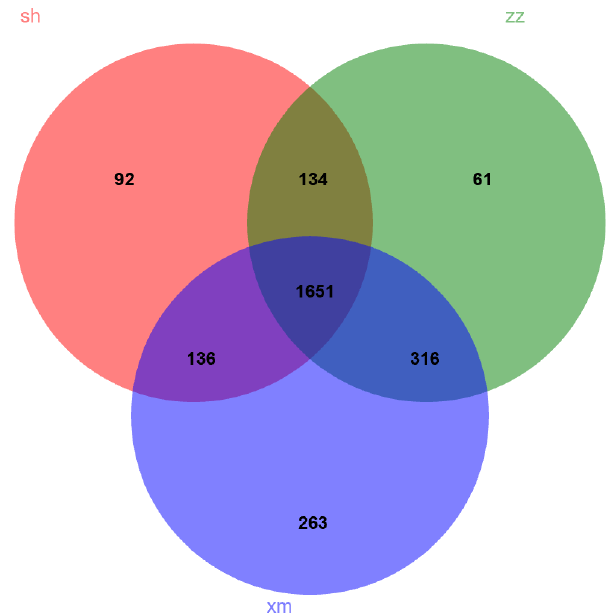
Figure 4. Venn diagram showing the similarity of 16S sequences between Shanghai (sh), Xiamen (xm), and Zhangzhou (zz).